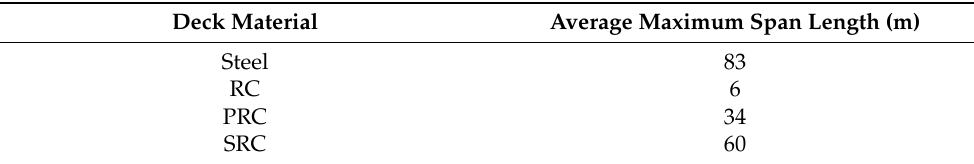
Table 1. Maximum span length as a function of deck material.